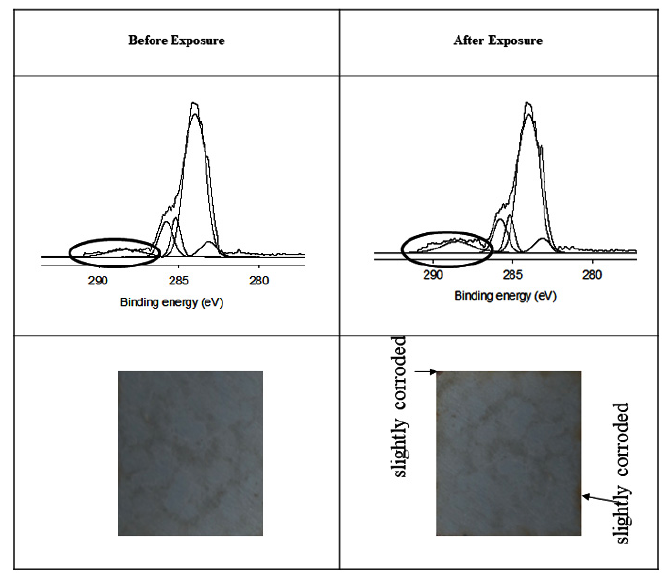
Figure 6. Photograph and XPS scan of exposed WBPU-PDMS-Ce coating.